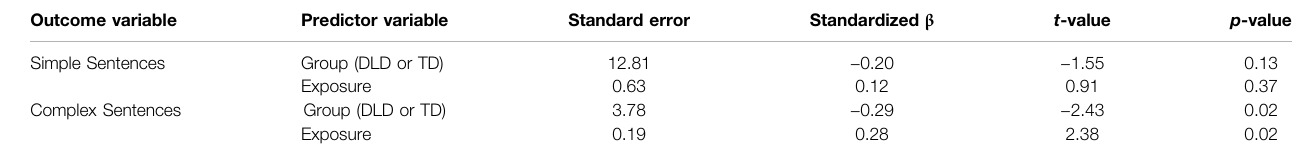
TABLE 4 | Linear regression results testing whether group membership is related to the production of simple and complex sentences.